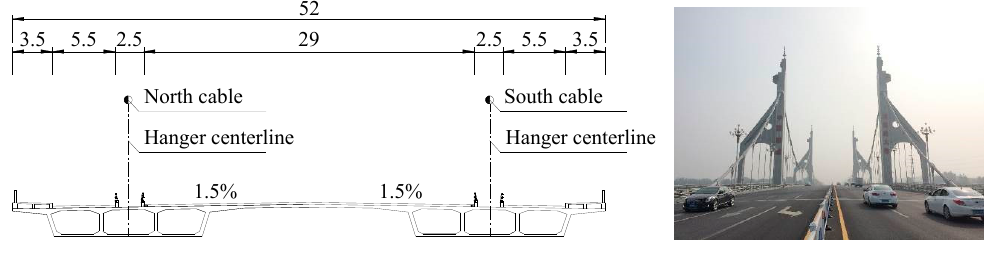
Figure 2. Cable system and extra-wide girder (Unit: m).